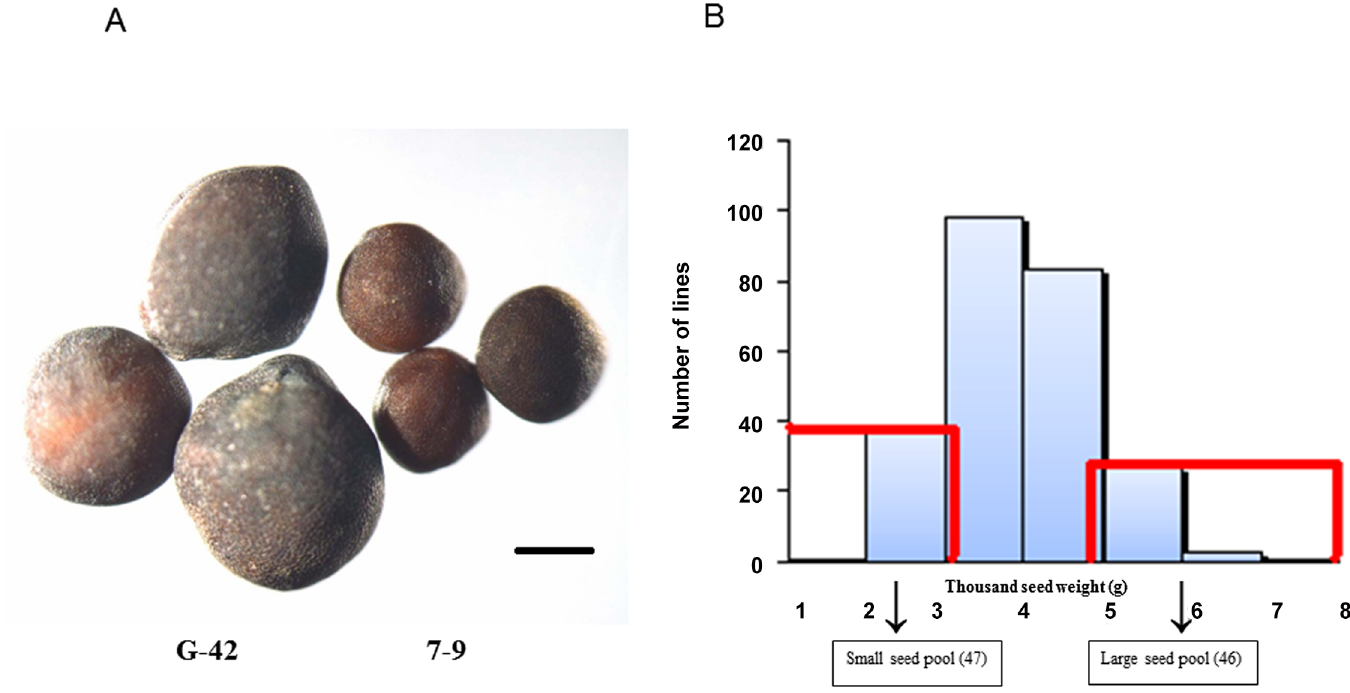
Fig 1. The seed phenotype of two parent lines and two extreme pools were selected by 1000-seed weight (TSW) data for SLAF-sequencing. (A) Seeds of the large-seed line G-42 and the small-seed line 7 – 9. (Scale bar, 1 mm) (B) Forty-six lines with the heaviest TSW and 47 lines with the lightest TSW were selected and pooled for SLAF-sequencing (the histogram was drawn based on the TSW data collected from 250 DH lines in May, 2014).